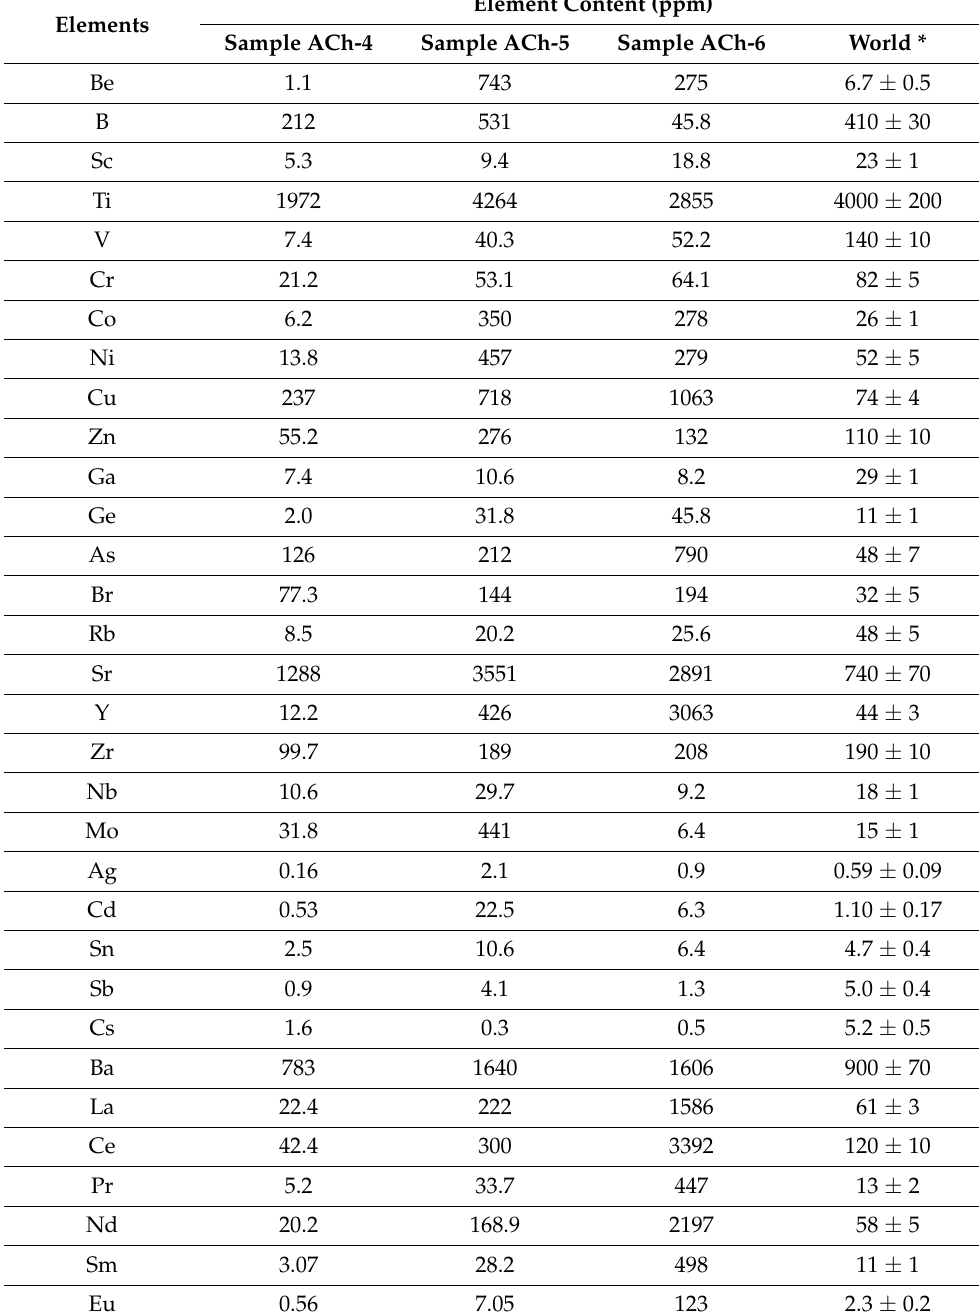
Table 5. The content of trace elements in oxidized coal ash of the Aduunchuluun deposit (ppm, ash basis, analyzed by INAA and